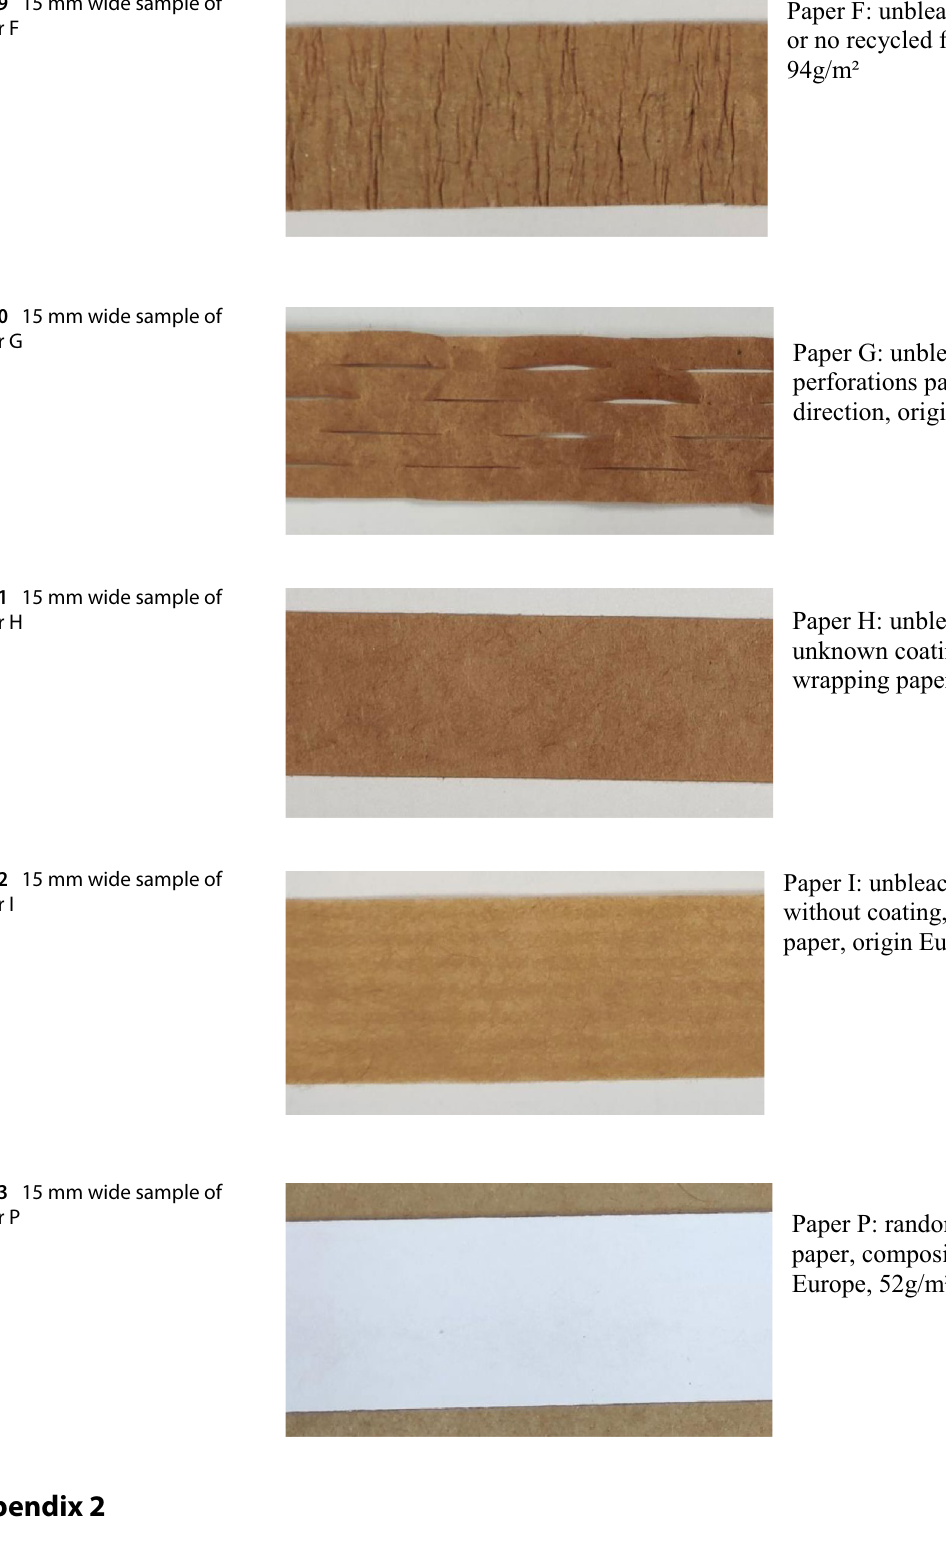
Fig. 19 15 mm wide sample of paper F